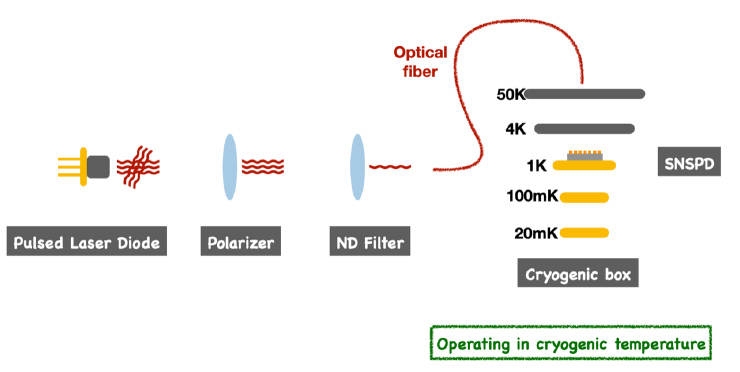
Figure 20. Single-photon calibration setup using SPAD.